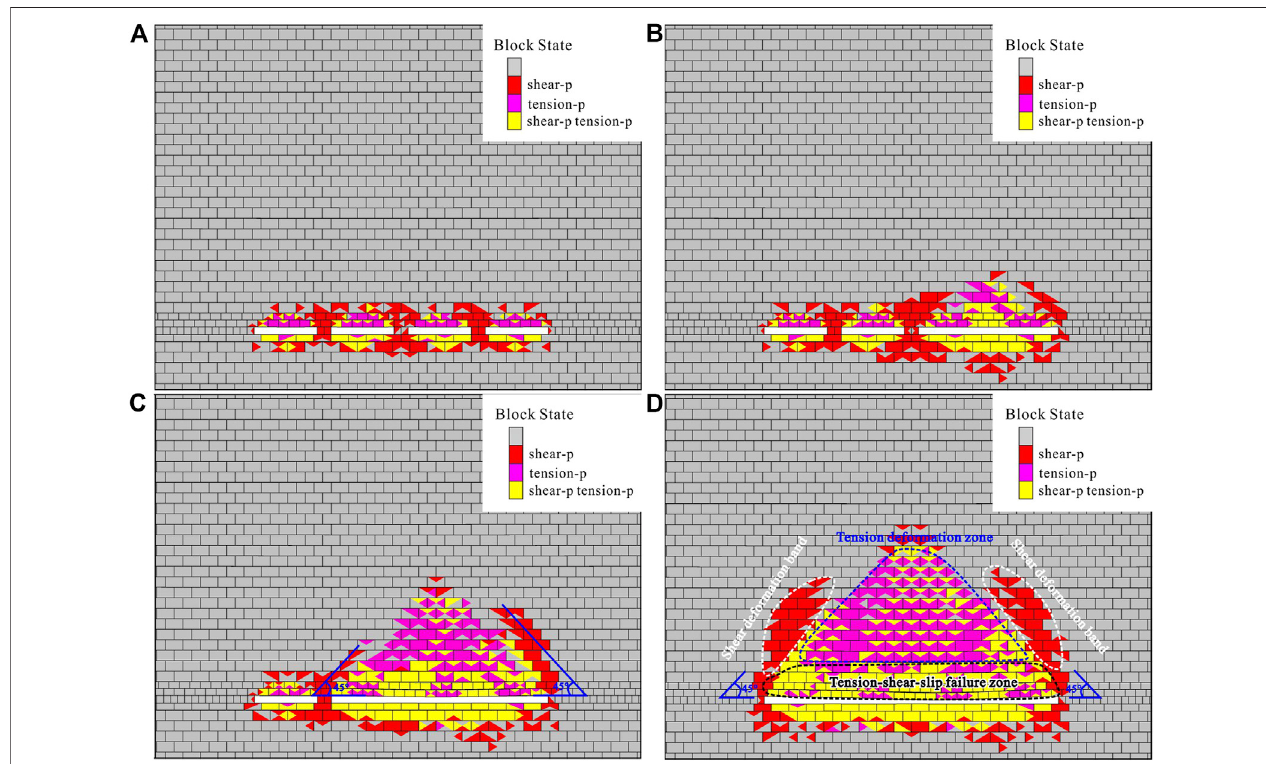
FIGURE 8 | The dynamic change of the plastic zone of the overlying strata in the model, mining distance of coalface: (A) 64 m, (B) 70 m, (C) 76 m, (D) 82 m.